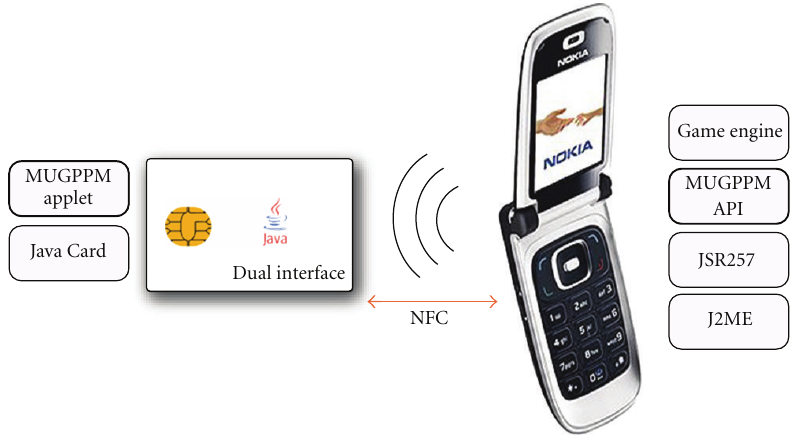
Figure 2: MUGPPM architecture for J2ME